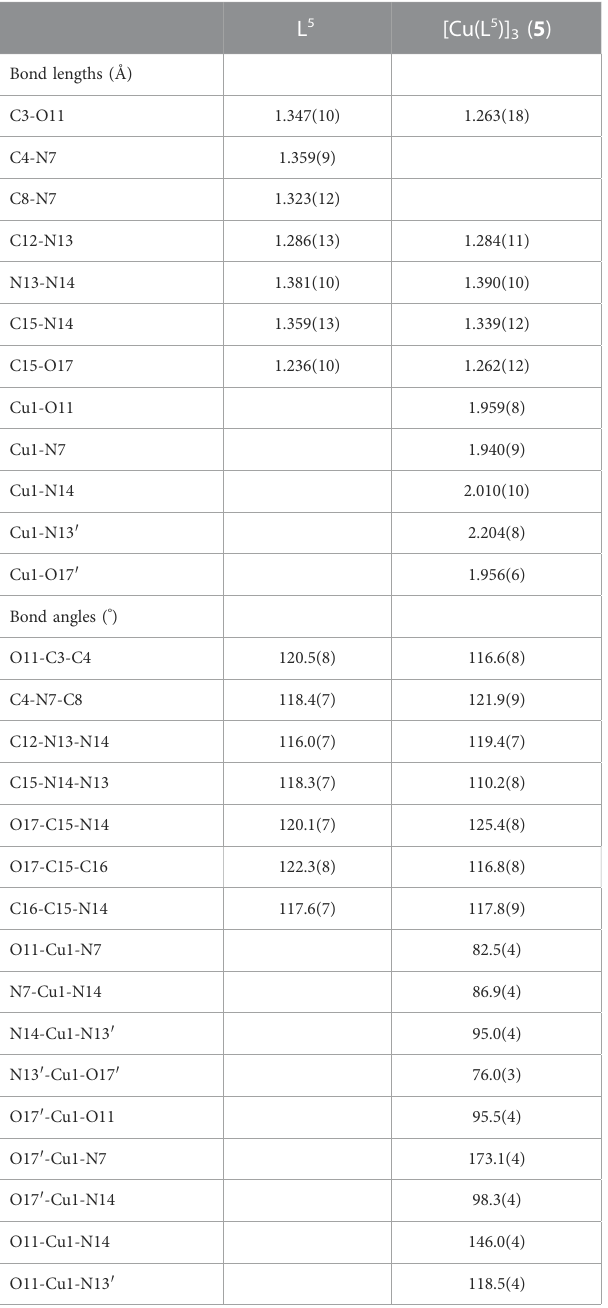
TABLE 1 Selected bond lengths (Å) and angles ( ° ) for L 5 and [Cu ( L 5 )] 3 ( 5 ). Atoms labelledwithaprime(´)belongtoasecondligandmoleculecoordinatedtothe same Cu(II)